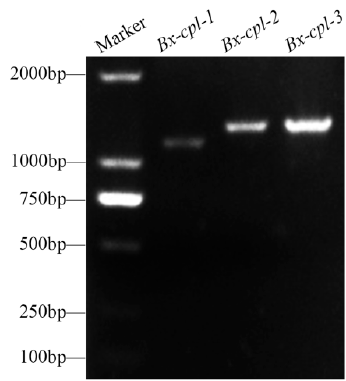
Figure 1. Bands of Bx-cpls full-length cDNA sequences after gel